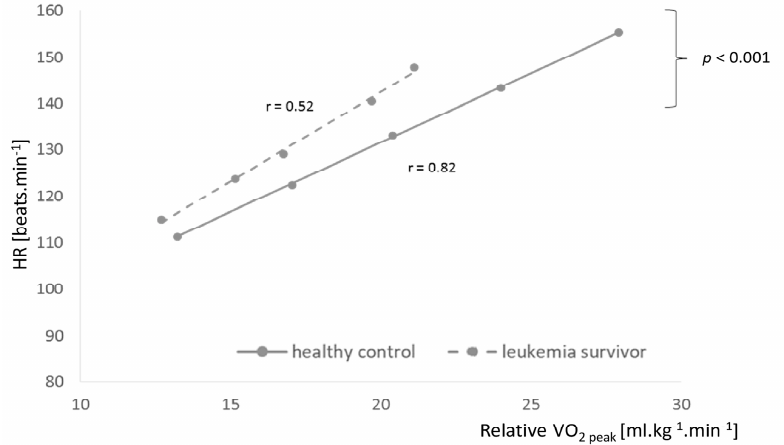
Figure 3. Individual regression for heart rate vs. the corresponding relative VO 2 peak for leukemia survivors and healthy controls. Data are means ± SD.